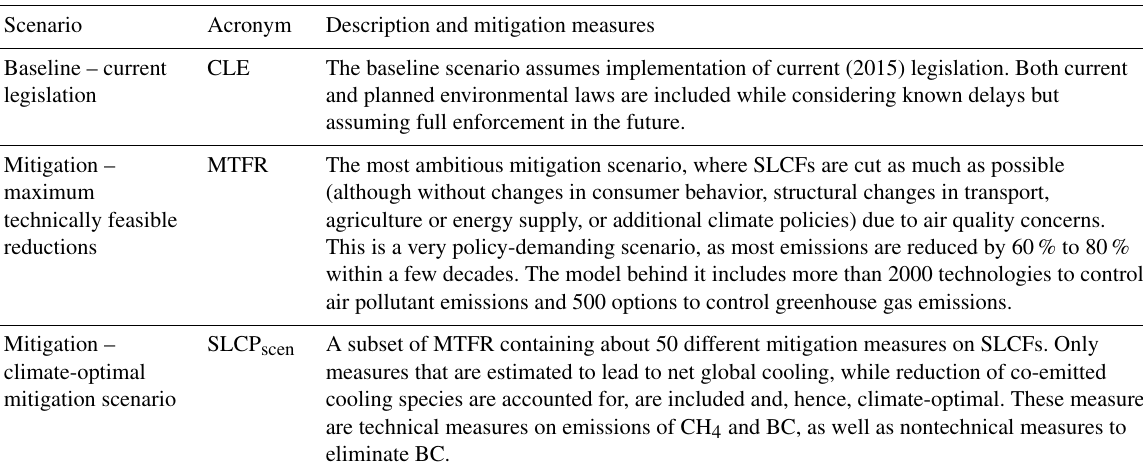
Table 1. An overview of the three emission scenarios with different mitigating ambitions investigated in this study. The emission inventories and scenarios for the period 1990–2050 have been produced by Klimont et al. (2017, 2019) and Stohl et al.